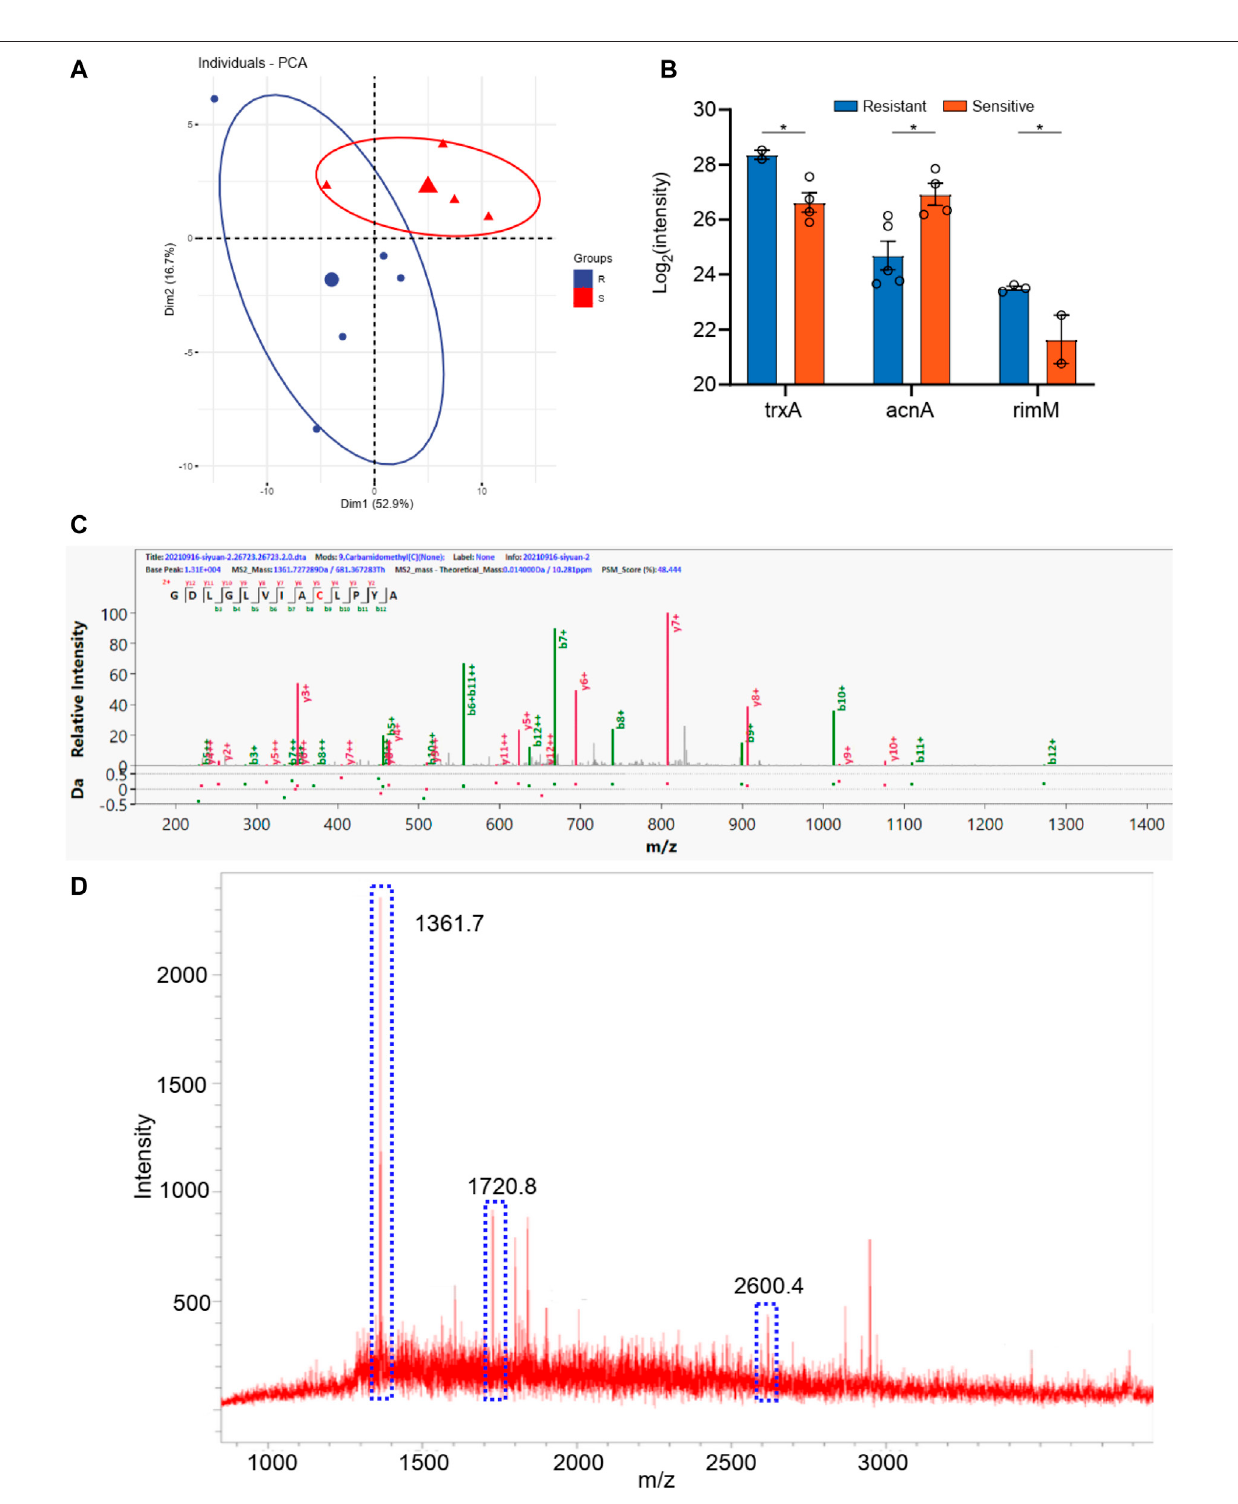
FIGURE 4 | (A) The PCA analysis of drug resistance of piperacillin for Klebsiella pneumonia ; (B) The differential proteins between drug resistance group and drug sensitive group; (C) The corresponding differential peptides and (D) the fi nger print in MALDI TOF.